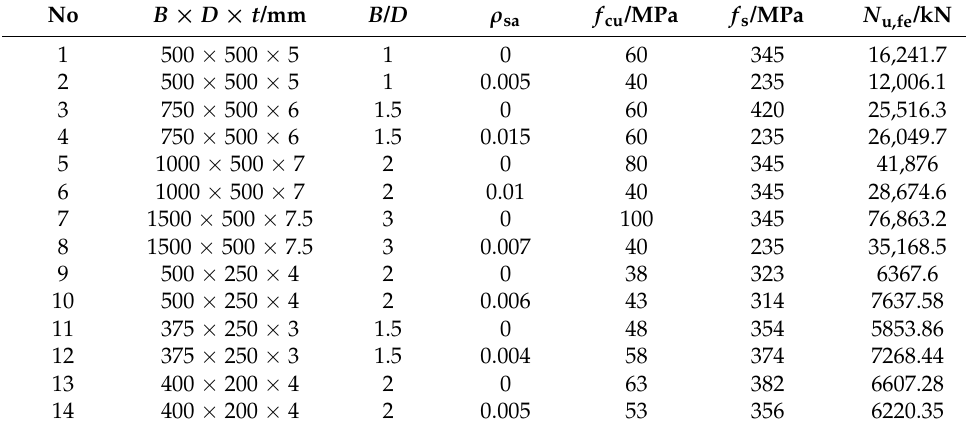
Table 3. Properties of